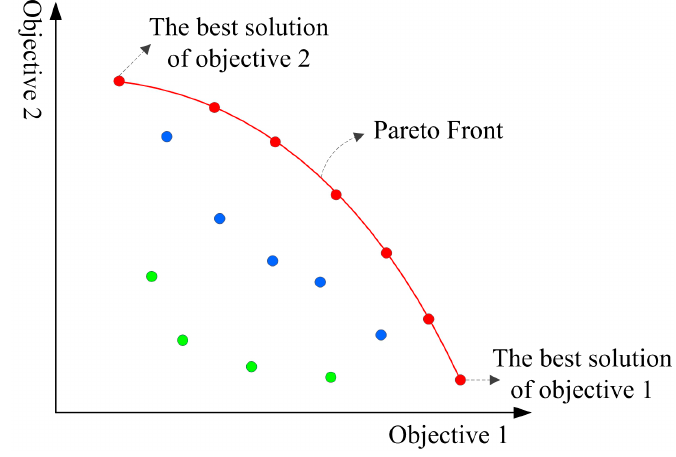
Figure 1. Pareto solutions.